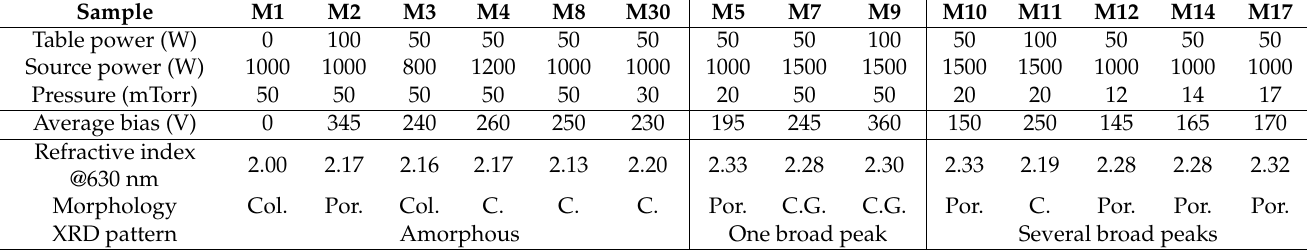
Table 1. Values of deposition parameters and corresponding refractive index, bias value, comments on layer morphology (Col. = Columnar, Por. = Porous, C. = Compact, G. = Grains), and XRD